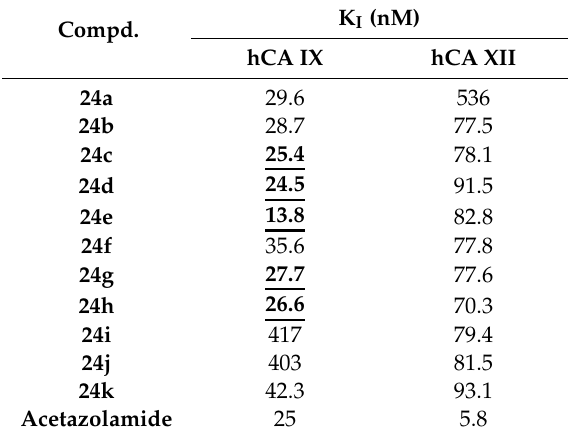
Table 9. CA IX and XII inhibition data for compounds 24a–k .